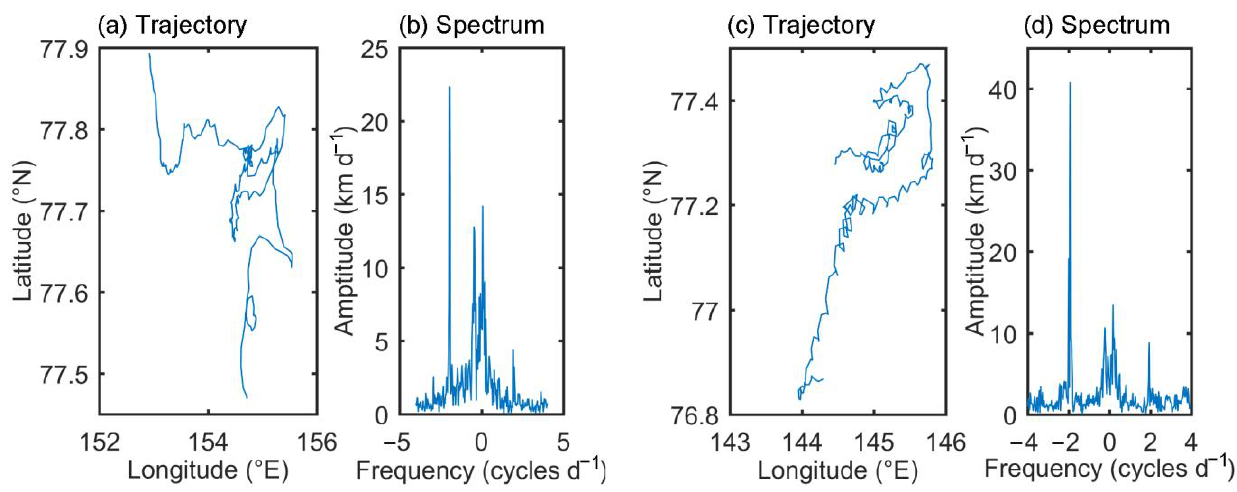
Figure 9. ( a ) The trajectory of IABP buoy (ID: 3004) from 26 June 1999 to 25 July 1999. ( b ) Rotary spectrum of the buoy drift velocity derived from the trajectory in ( a ). ( c , d ) Similar with ( a , b ), but for the IABP buoy (ID: 53095, 23 November 2019 to 22 December 2019).